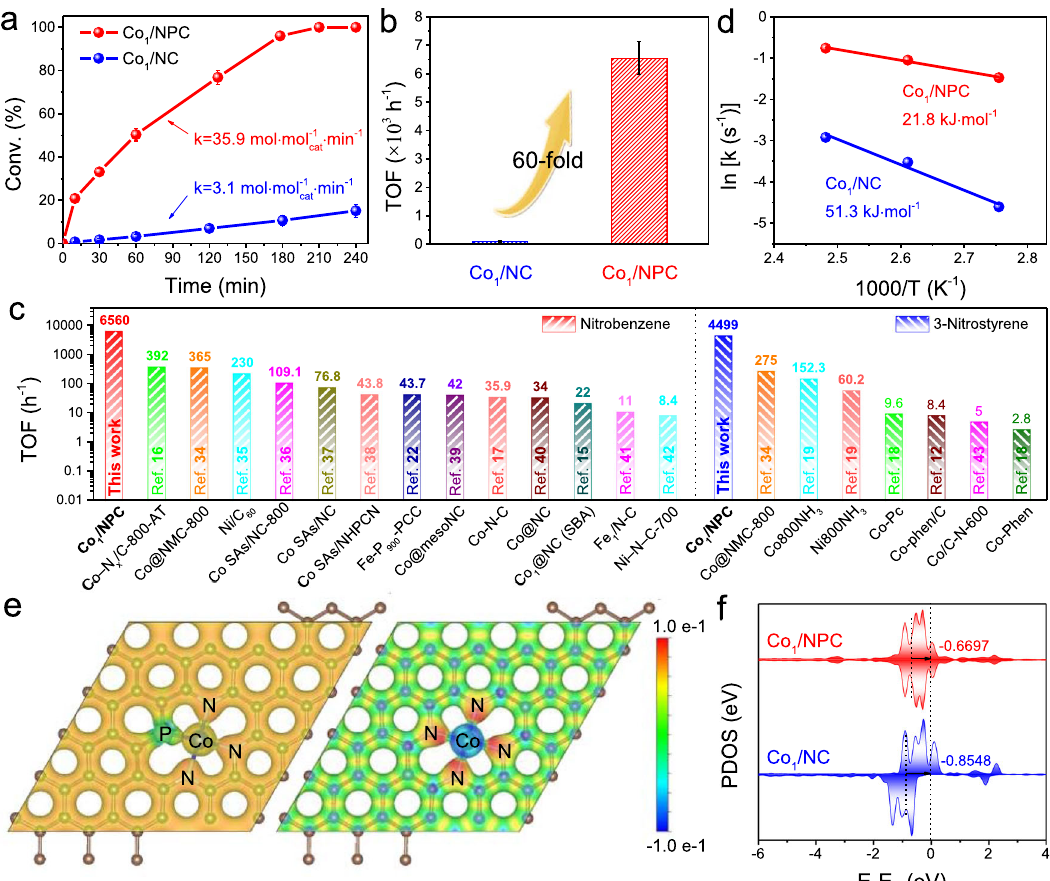
Fig. 3 Catalytic performances and kinetic process studies. a Time course of nitrobenzene conversions over Co 1 /NPC and Co 1 /NC samples. The standard deviations were derived from three independent trials. Reaction conditions: 5 mg catalyst, 2 mmol nitrobenzene, 40 mL EtOH/H 2 O (v:v = 4:1), 110 °C, 3 MPa H 2 . b TOF of Co 1 /NPC and Co 1 /NC for the nitrobenzene hydrogenation. The TOF values were calculated at about 20% conversion. c The TOF values comparison of recently reported transition metal catalysts. d The experimental Arrhenius plots of Co 1 /NPC and Co 1 /NC. e Electron-density isosurface of Co atoms in two models. Blue color indicates positive charges and red color indicates negative charge. f Partial density of states (PDOS) of Co atoms in Co 1 /NPC and Co 1 /NC, the zero-energy corresponds to the Fermi level, and the d-band centers are inserted with the short